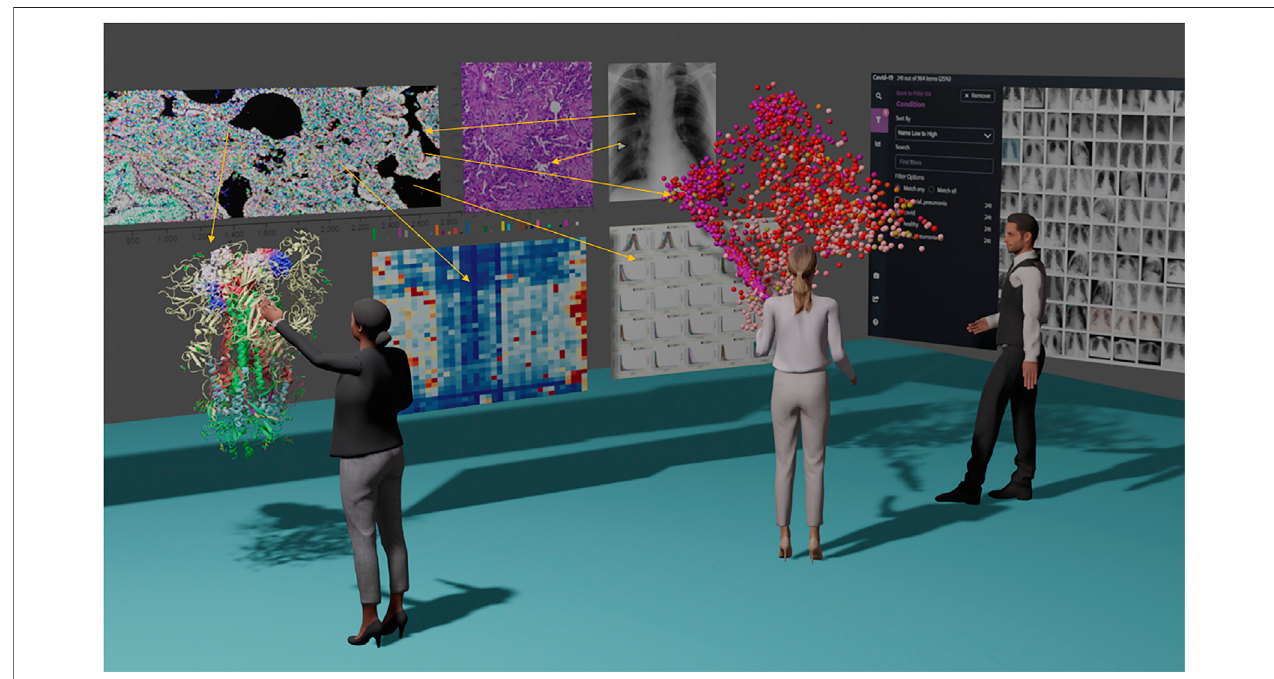
FIGURE1 | “ Metaverse Evidence Wall ” concept showing a combination ofdifferentpackages and data types consolidated into asingle spacevirtual environment. Theexampleshowsamulti-disciplinarygroupanalyzinga fi ctitiousCOVID-19spatialomicsandsinglecelldatasetprojectedin3Dscatterplot.Fromlefttorightmolecular imaging (with colored marker overlay), H and E stain, and patient cohort x-ray imaging are shown. Heatmaps derived from spatial analysis allow cellular phenotyping in conjunctionwiththelocationofthescatterplotandimaging.Meanwhile,astructuralbiologistmanipulatestheCOVIDspikeproteininaXRproteinviewerlookingfor variations in the patient ’ s genetic background that change binding af fi